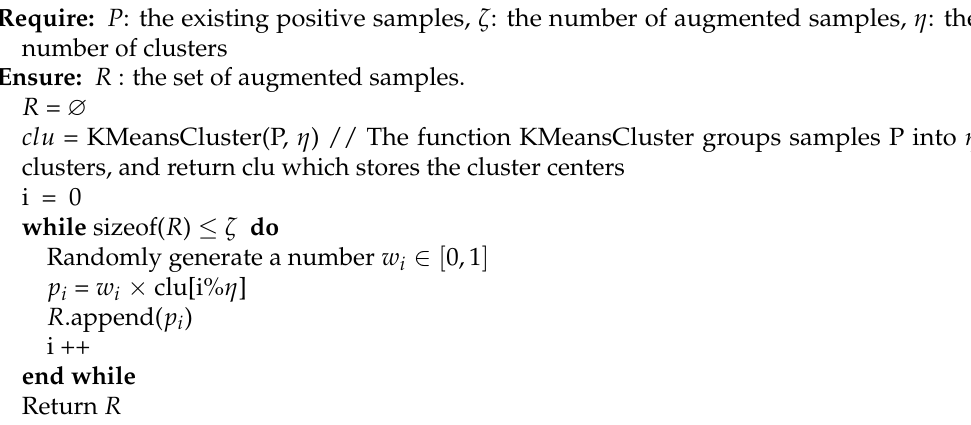
Algorithm 3 Clustering-based Oversampling for Minority